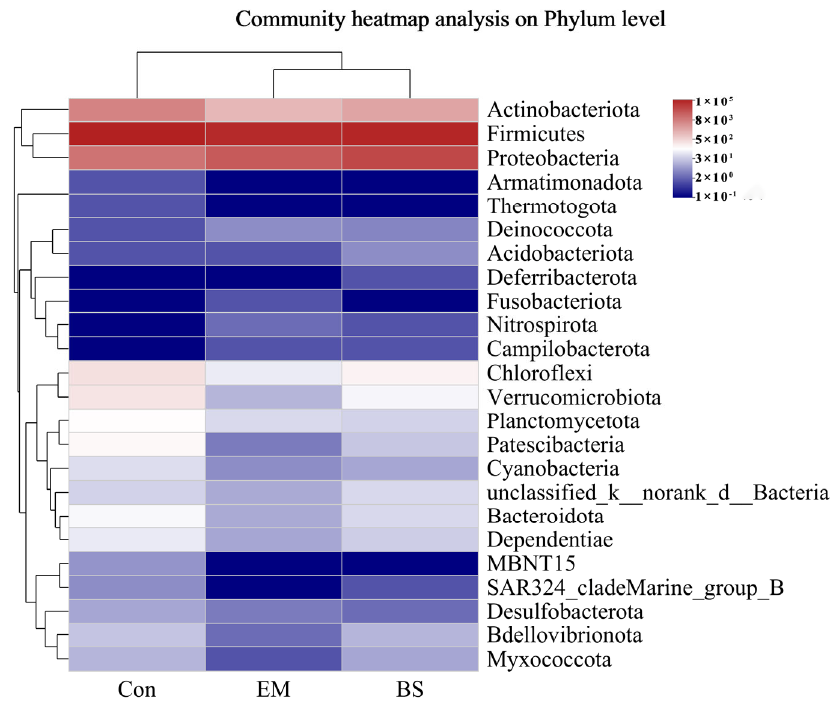
Figure 2. Analysis of dominant flora at phylum level in the intestine of M. rosenbergii .